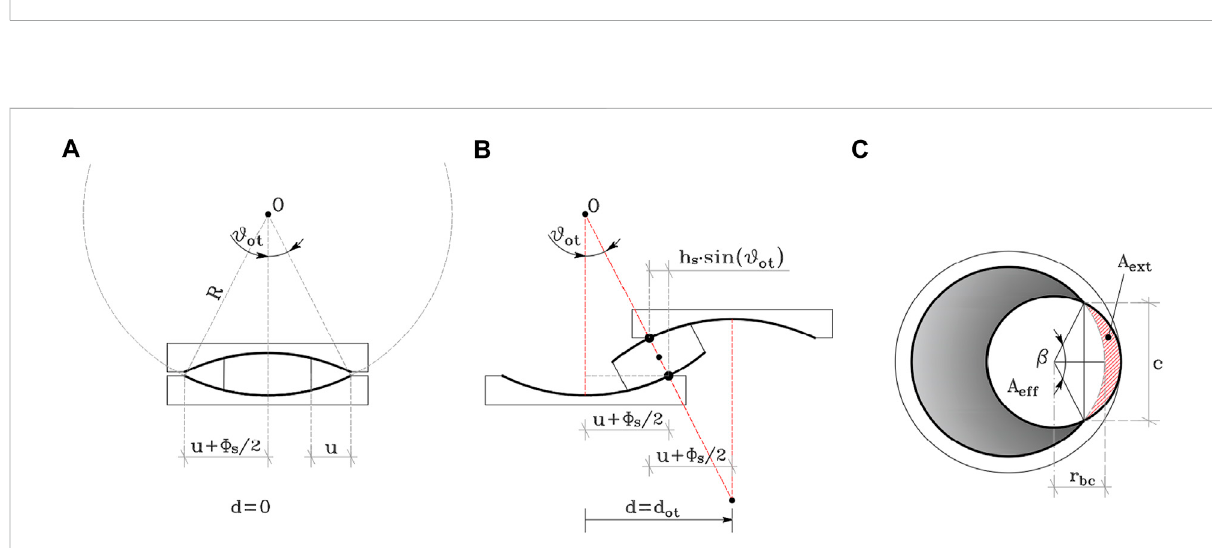
FIGURE 4 Cross-sectionoftheDCCSSin: (A) staticconditions (A) andtheover-strokeregime (B) . (C) Planarviewoftherigidsliderandthehousingplatein the over-stroke